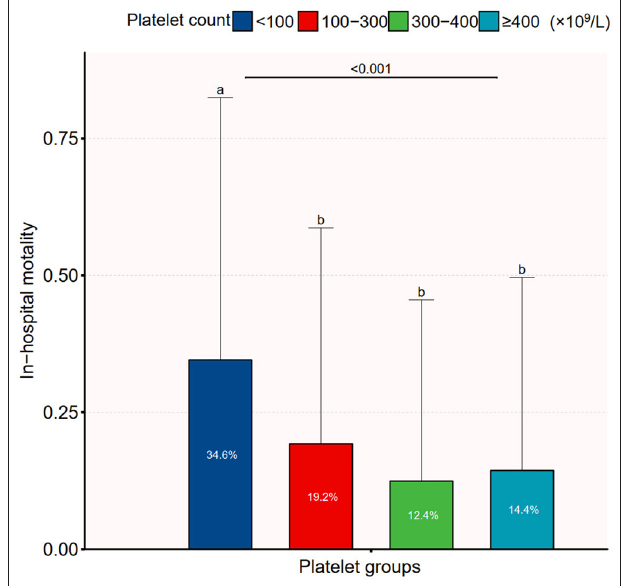
FIGURE 1 | In-hospital mortality in different platelet count groups.